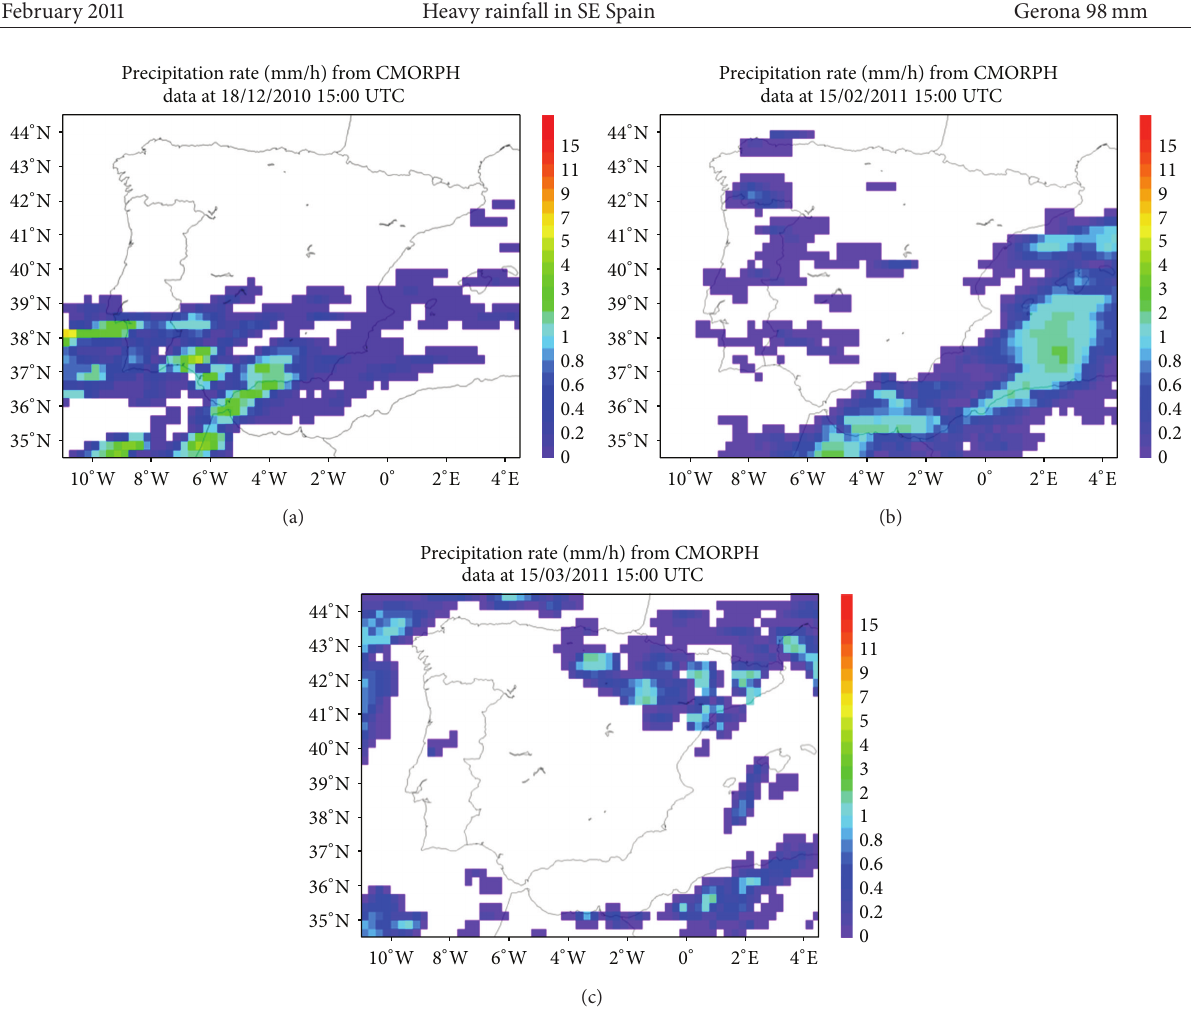
Figure 3: Precipitation over Spain based on CMORPH 3 hr data with 0.25-degree resolution for all 3